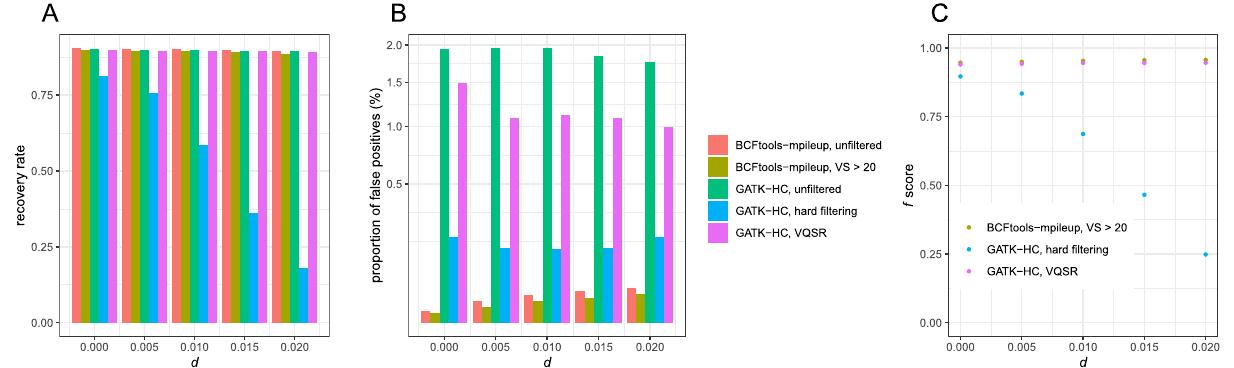
Figure 2. Variant calling performance using bowtie2 ( A ) The recovery rate, ( B ) the proportion of false positives, and ( C ) f scores of SNV datasets generated by Bcftools or GATK.